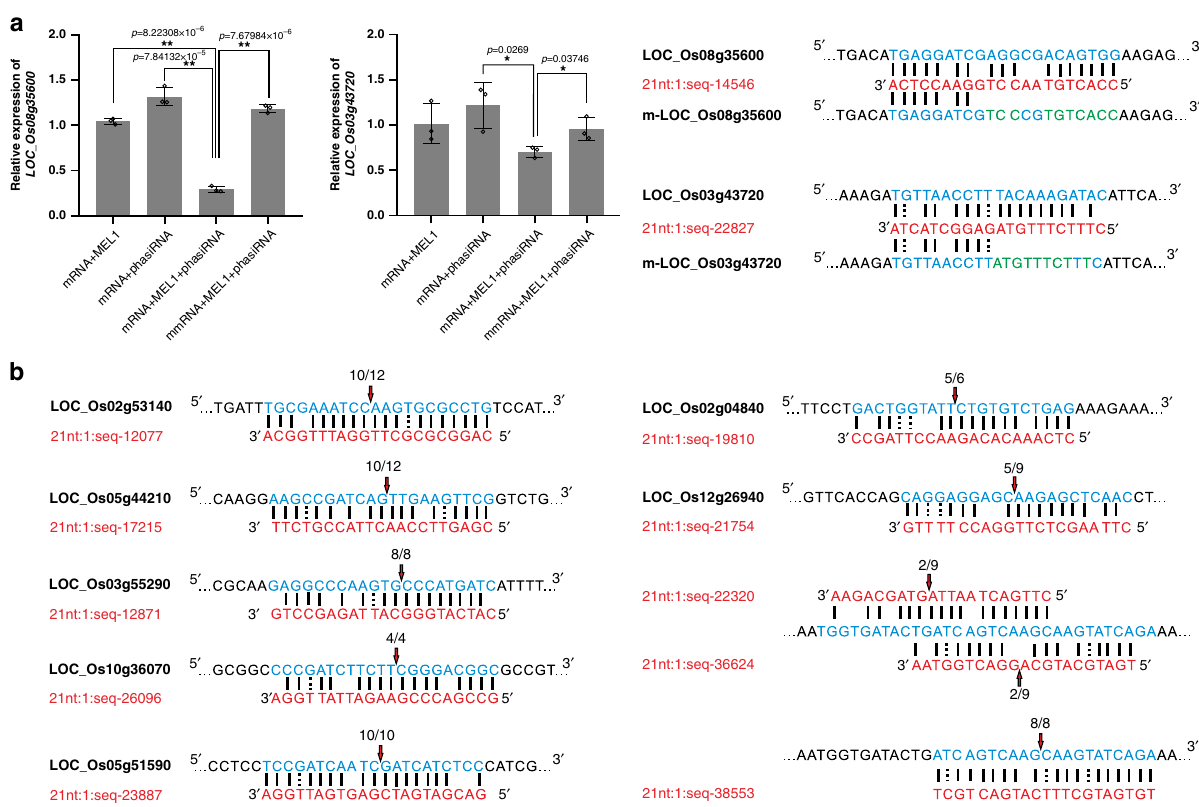
Fig. 3 Validation of phasiRNA target genes. a Validation of the requirement for phasiRNAs, phasiRNA-binding sequence and MEL1 for the downregulation of target genes in a rice protoplast transient transformation system and analysis by qRT-PCR. Values are means ± SD ( n = 3 replicates). The phasiRNAs are marked in red, binding sites are marked in blue, and the mutated sequences of the binding sites are marked in green. Signi fi cant differences were identi fi ed at the 5% (*) and 1% (**) probability levels using the two-tailed paired t -test. b 5 ′ - RACE veri fi cation of the cleavage of seven target genes by different phasiRNAs. PhasiRNAs are marked in red, binding sites are marked in blue, the arrows represent the cleavage site, and the numbers above the binding sites indicate the number of the cleavage products matched at the site to that of the total cleavage